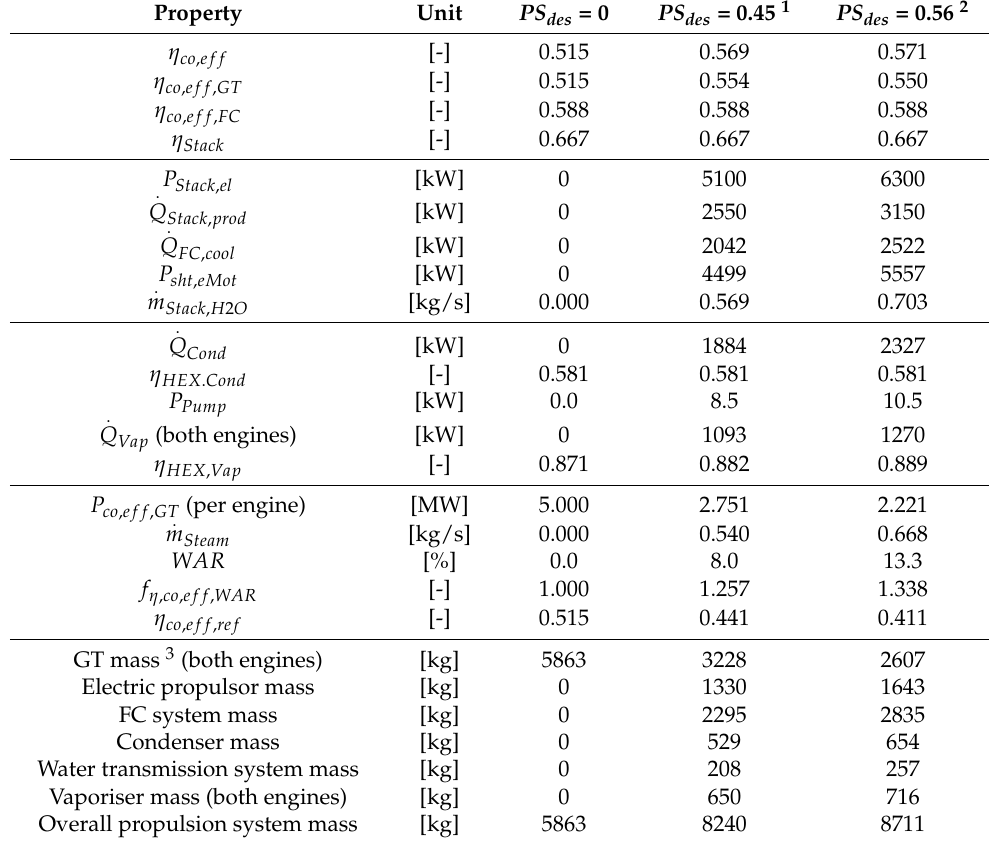
Table 3. Summary of power system performance and mass properties for selected design cases.